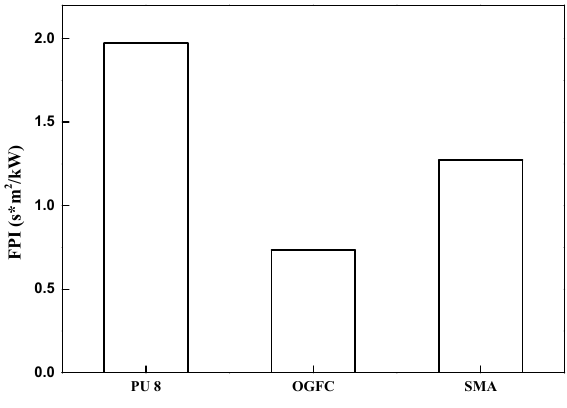
Figure 14. Comparison of fire proceeding index (FPI) among PU, OGFC, and SMA.